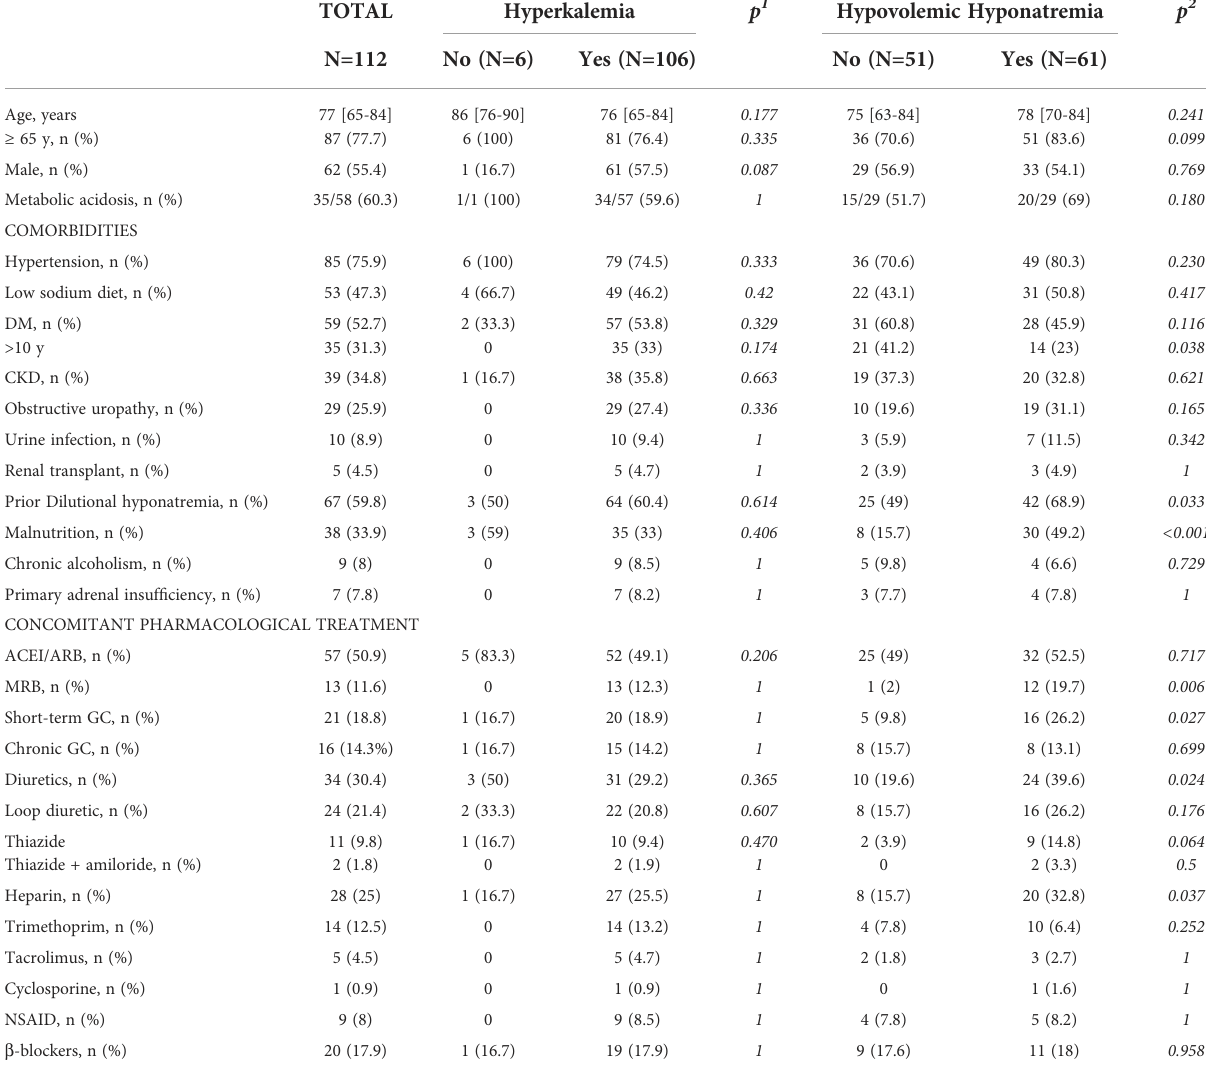
TABLE 2 Medical history and concomitant treatment at diagnosis of the cases according to the presence of hyperkalemia and hypovolemic hyponatremia. TOTAL Hyperkalemia p 1 Hypovolemic